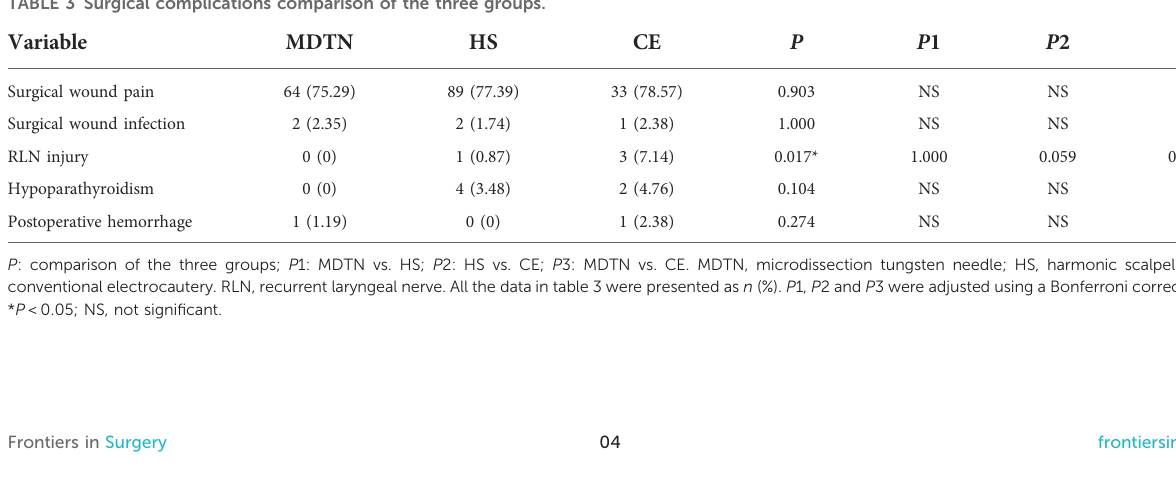
TABLE 3 Surgical complications comparison of the three